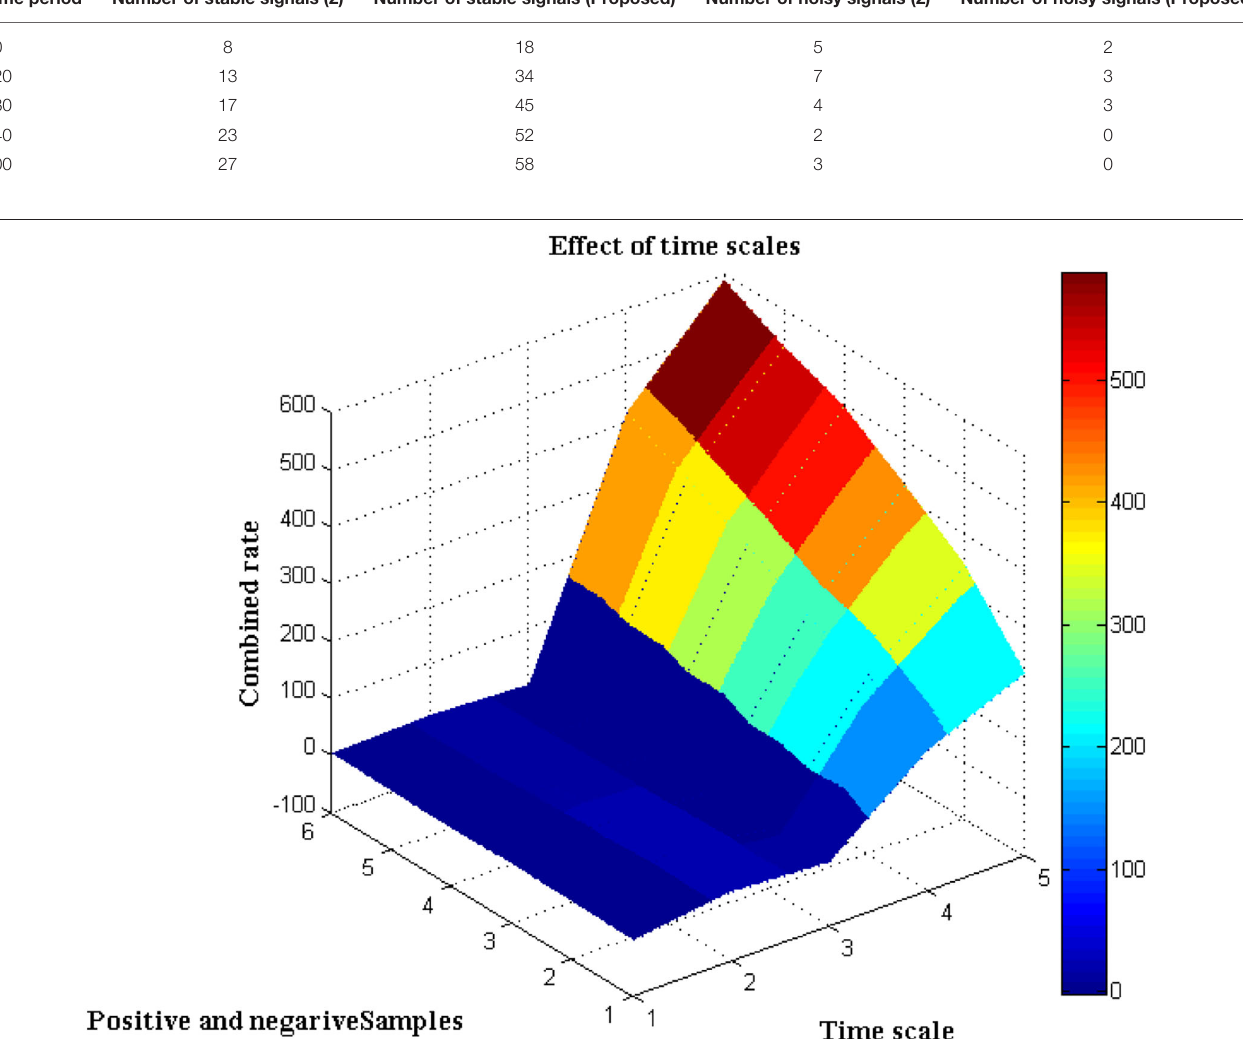
FIGURE 3 | Time scale vs. Samples.